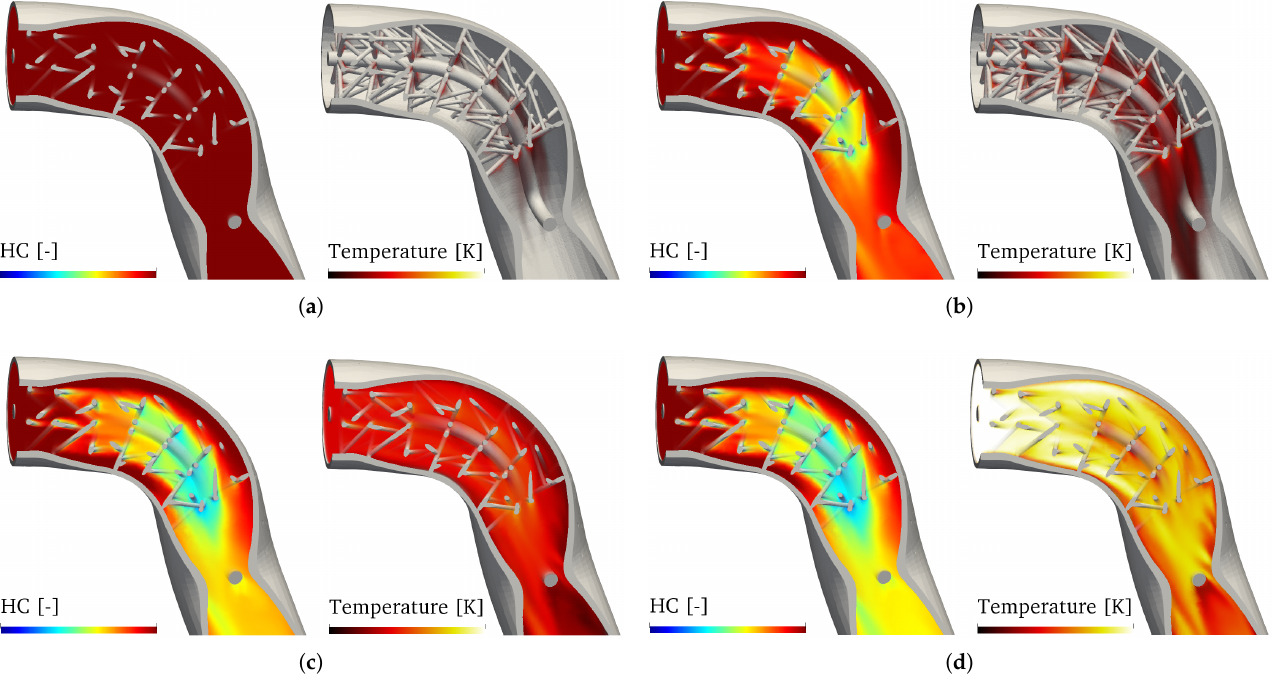
Figure 16. Cold start assessment: EHC–POCS single manifold—HC concentration and tempera- ture distributions. ( a ) time = 2.5 s; ( b ) time = 5.0 s; ( c ) Time = 7.5 s; ( d ) time = 10.0